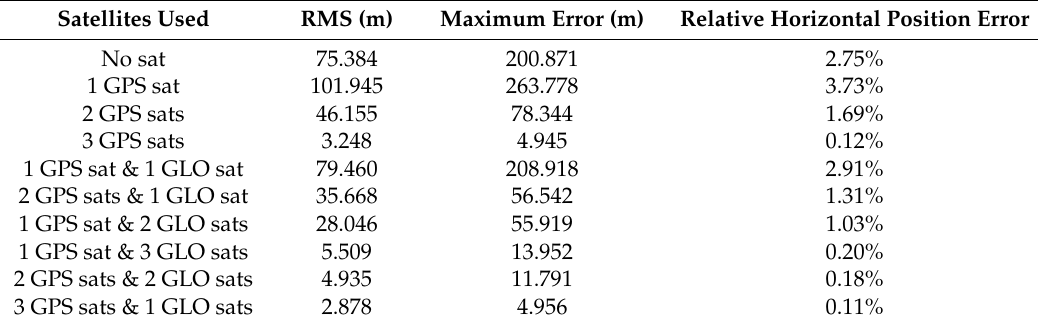
Table 3. Summary of horizontal errors using different satellites. GLO: GLONASS; sat: satellite.